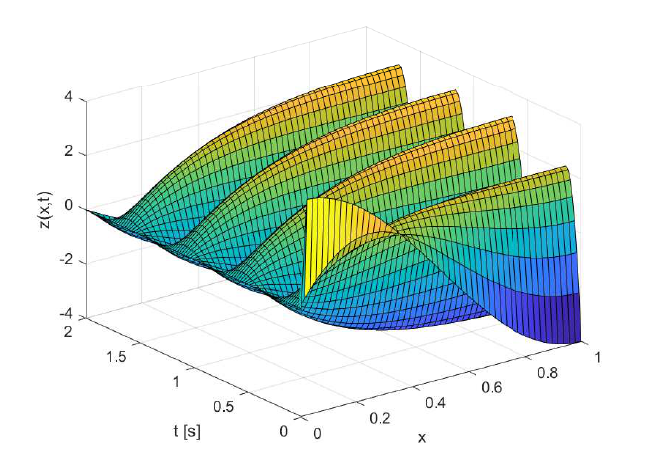
Figure 3. Regulator performance with Γ = [ 4.9348,12, − 1,0 ] : ( a ) Comparison of the output y ( t ) and the reference signal y r ( t ) , ( b ) Error between y ( t ) and y r ( t ) .